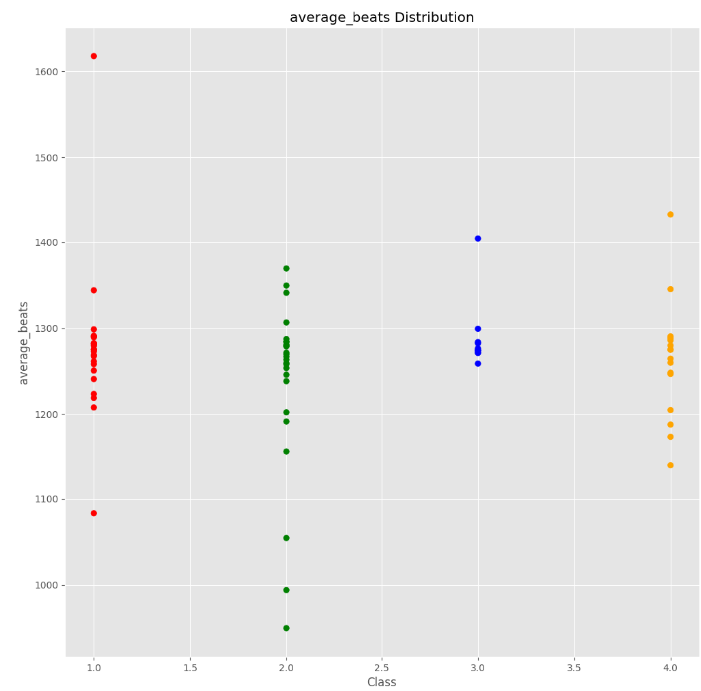
Figure 3. Audio features file.